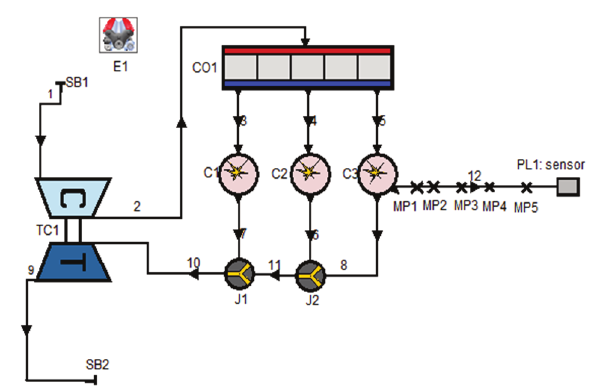
Fig. 2. Model of the research object in the AVL Boost program The pipe number 12 it’s the indicator channel MP sym- bols are the marked places then find the pressure